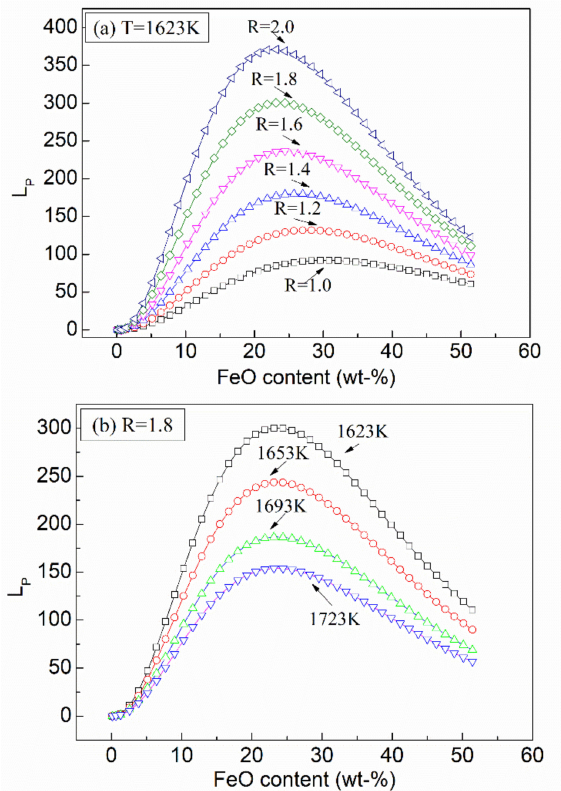
Figure 3. Changes of phosphorus distribution ratio with FeO content ( a ) temperature fixed at 1623 K, various basicity; ( b ) basicity fixed at 1.8, various